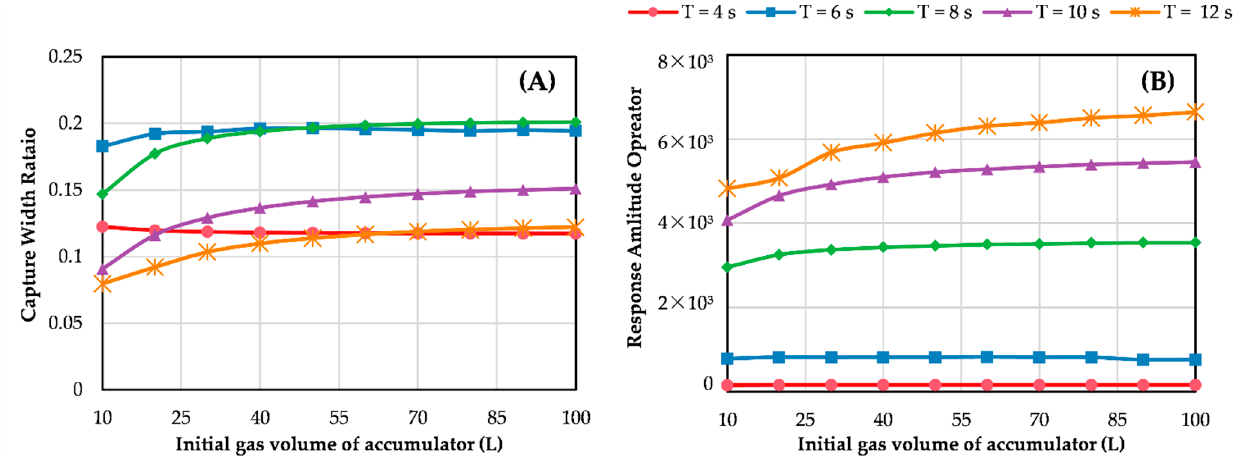
Figure 9. Influence of initial gas volume of accumulator on the performance of the hybrid system under wave height of 1.5 m. ( A ) Variation of CWR. ( B ) Variation of pitch motion RAO.